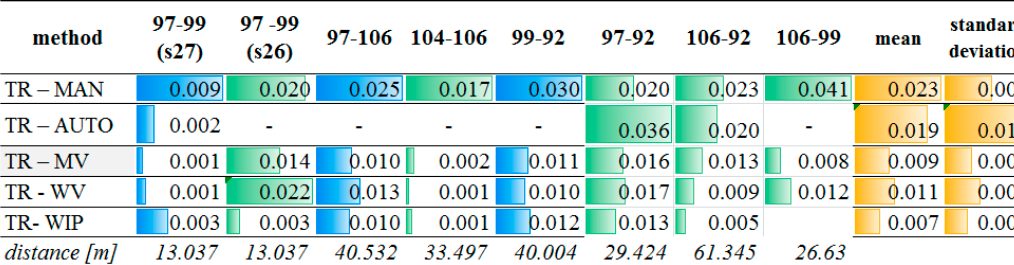
Figure 13. Accuracy check for the chosen low-quality targets.